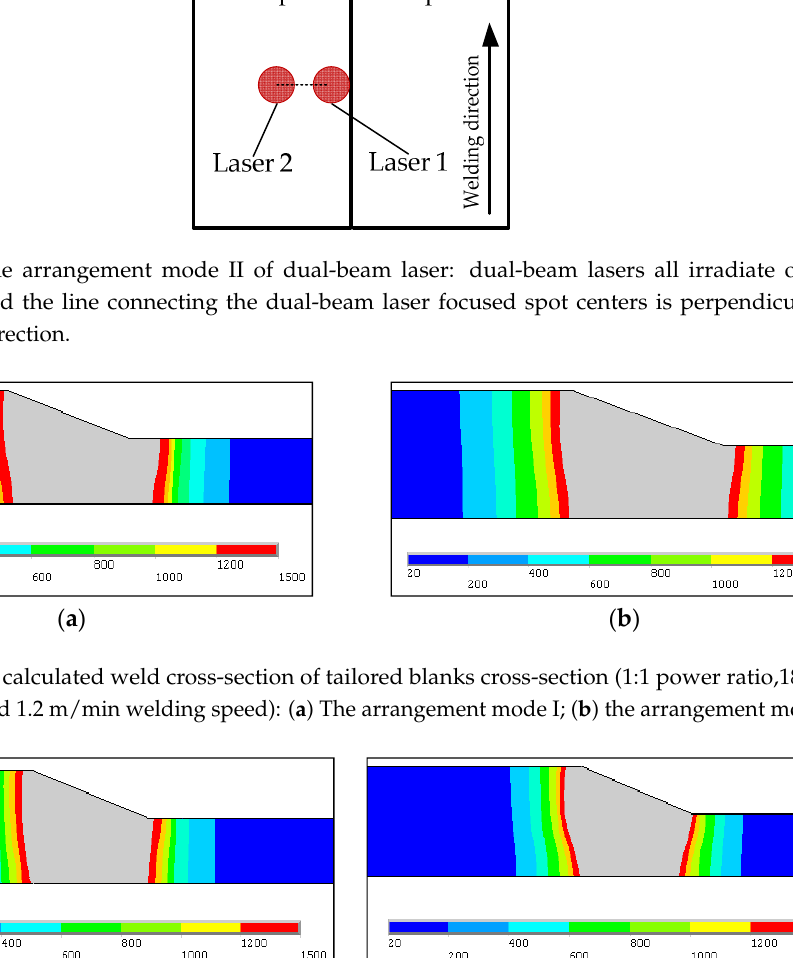
Figure 12. The calculated weld cross-section of tailored blanks cross-section (2:1 power ratio,1800 W total power, and 1.2 m/min welding speed): ( a ) The arrangement mode I; ( b ) the arrangement mode II.